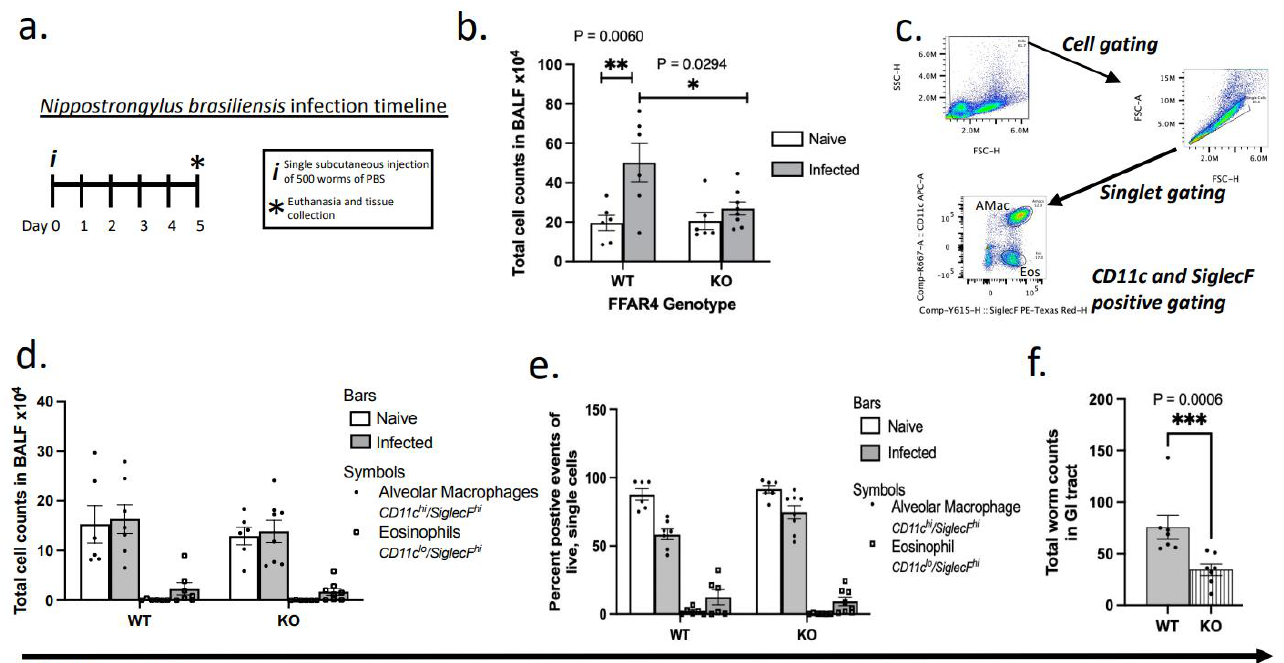
Figure 2. The Ffar4 − / − phenotype of dampened immune influx without changes to cell populations is confirmed in another model: Nippostrongylus brasiliensis (Nb) infection. ( a ) A schematic of the helminth infection timeline. Mice were subcutaneously injected with 500 Nippostrongylus brasiliensis L3 larvae in 200 μL PBS or PBS only on day 0. Mice were euthanized on day 5 post-infection. ( b ) Helminth-infected WT mice had significantly elevated cell counts in the airway compared with their naïve controls, as measured by total cell counts in the BALF; this effect was significantly dampened by Ffar4 -deficiency, being comparable to naïve controls. ( c – e ) BAL cell differentials, determined by flow cytometry, were not significantly altered by Ffar4 presence, though the infection significantly impacted cell differentials by promoting eosinophilia in the airways (two-way ANOVA, main effect p < 0.0001). Expressing the data as totals or percentages did not alter this outcome. These data were generated from two separate experiments with representative groups included in each experiment. ( f ) Ffar4 -deficiency dampened the presence of worms in the GI tract, with significantly fewer worms counted from the jejunum of Ffar4 -null mice. * p < 0.05; ** p < 0.01; *** p < 0.001.